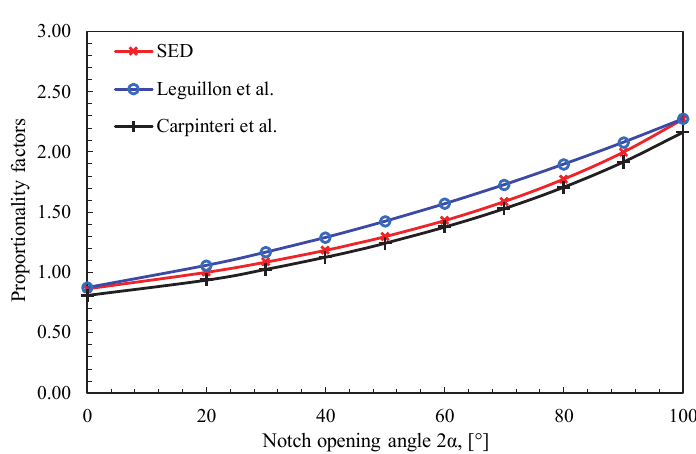
Figure 2: Comparison among proportionality factors given by Eqs. (6), (10) and